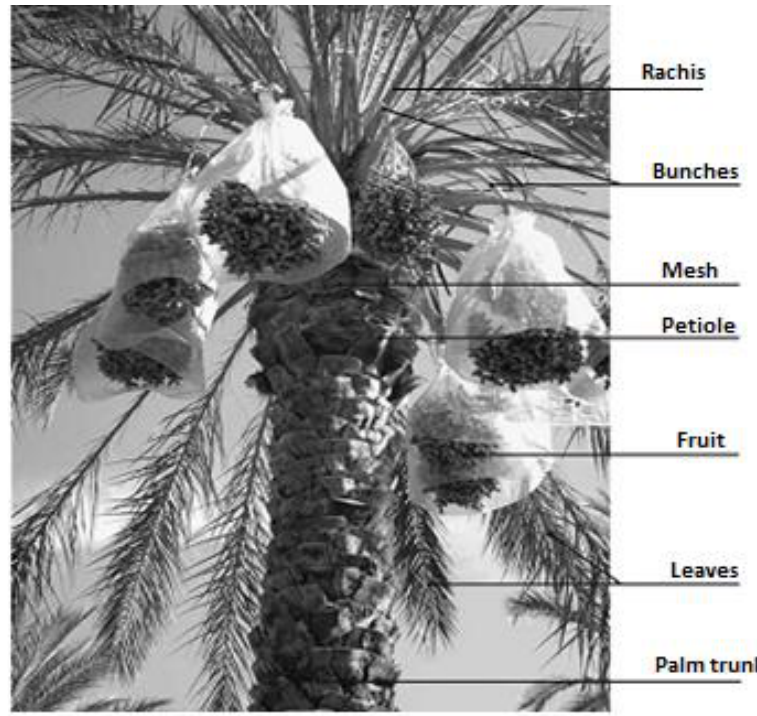
Figure 1. Date palm aerial parts [23].